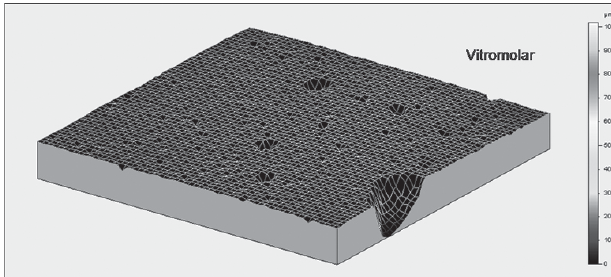
Fig. 2. 3D image of the profile of the glass ionomer cement